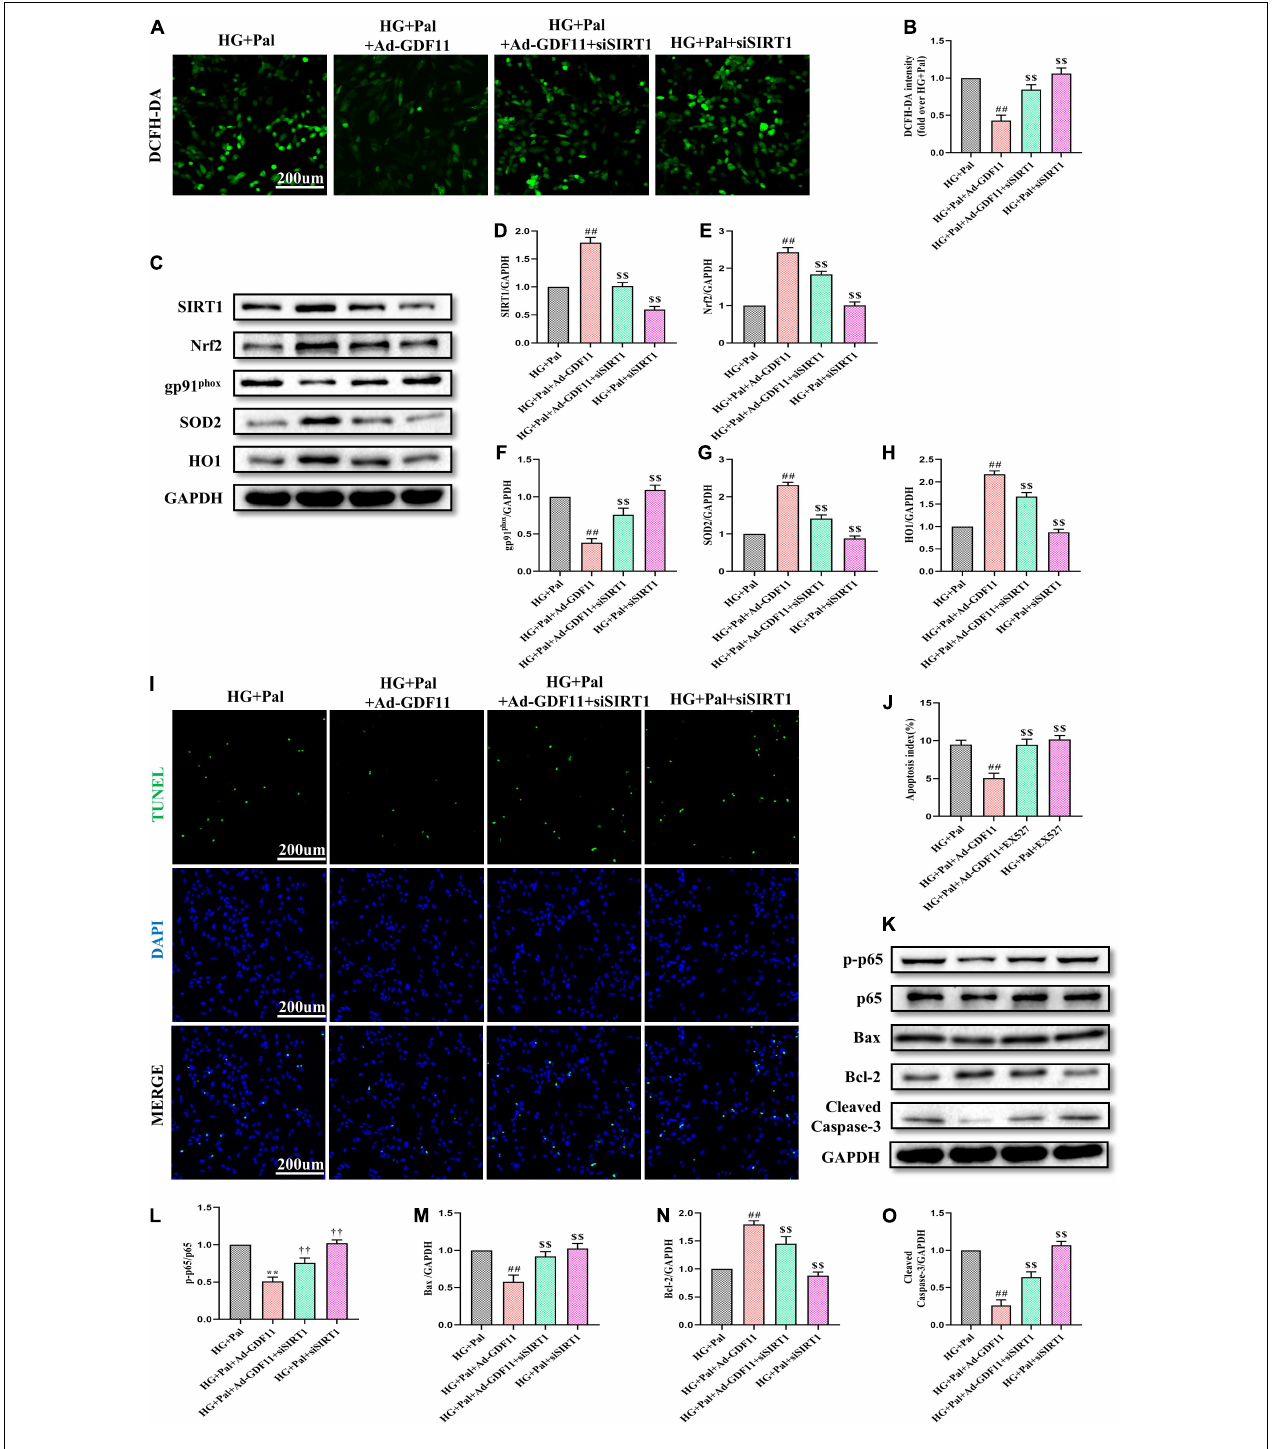
FIGURE 8 | SIRT1 siRNA diminished GDF11-induced inhibition of oxidative stress and apoptosis in H9c2 cells. (A) Representative images of 2’,7’-dichlorofluorescein diacetate (DCFH-DA) staining (scale bar = 200 µ m). (B) DCFH-DA fluorescence intensities. (C) Representative blots of SIRT1, Nrf2, gp91 phox , SOD2, and HO1. (D) Quantitative expression of SIRT1. (E) Quantitative expression of Nrf2. (F) Quantitative expression of gp91 phox . (G) Quantitative expression of SOD2. (H) Quantitative expression of HO1. (I) Representative images of TUNEL staining (scale bar = 200 µ m). (J) Apoptotic ratio. (K) Representative blots of p-p65, p65, Bax, Bcl-2, and Cleaved Caspase-3. (L) Quantitative analysis of the ratio of p-p65 to p65. (M) Quantitative expression of Bax. (N) Quantitative expression of Bcl-2. (O) Quantitative expression of Cleaved Caspase-3. Data are presented as the mean ± SEM, n = 5 or 6 per group. ## P < 0.01 versus the HG + Pal group, $$ P < 0.01 versus the HG + Pal + Ad-GDF11 group.